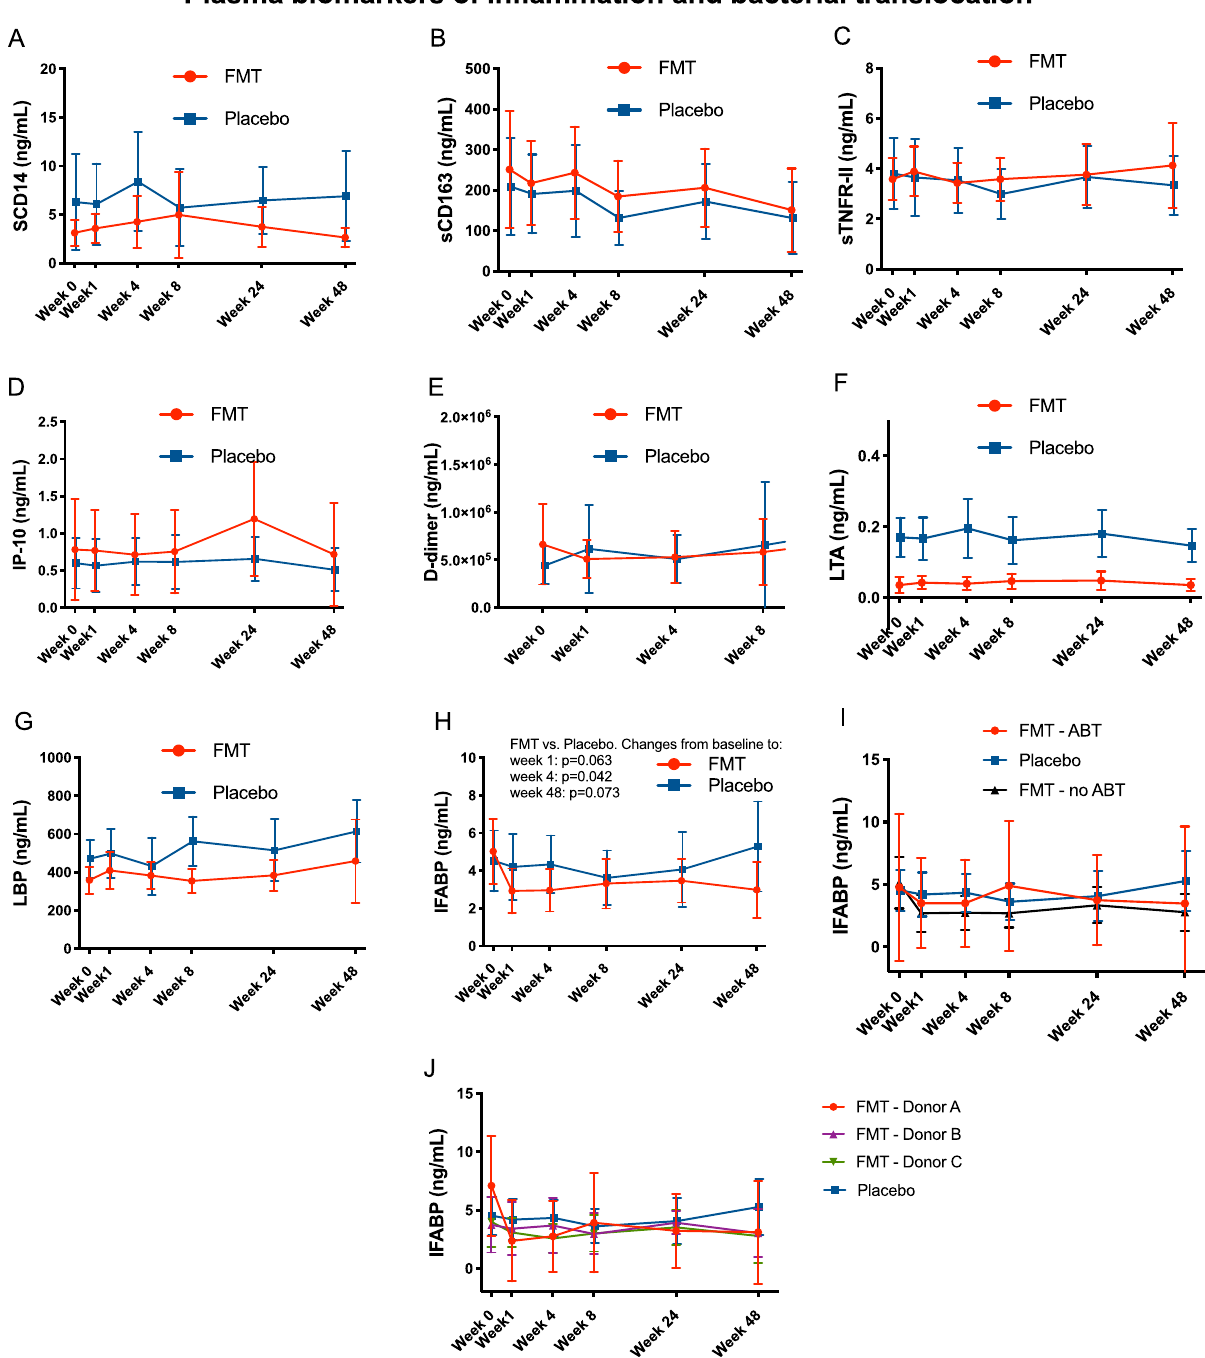
Fig. 6 Changes in plasma biomarkers of in fl ammation (A: sCD14, B: sCD164, C: sTNFR-II, D: IP-10, E: D-dimer) and bacterial translocation (F: LTA, G: LBP, H, I and J: IFABP). Lines represent mean values in the FMT (red) and placebo (blue) group. Vertical bars represent the 95% con fi dence intervals. Two-sided P values estimated using mixed models not adjusted for multiple comparisons showed no signi fi cant differences between treatment arms, unless otherwise indicated, and remained unchanged after adjustment for nadir CD4 and time since HIV diagnosis. Abbreviatures: FMT, fecal microbiota transplant. n = 172 biologically independent samples from 14 individuals in the FMT group and 15 individuals in the placebo group. Experiments were run in